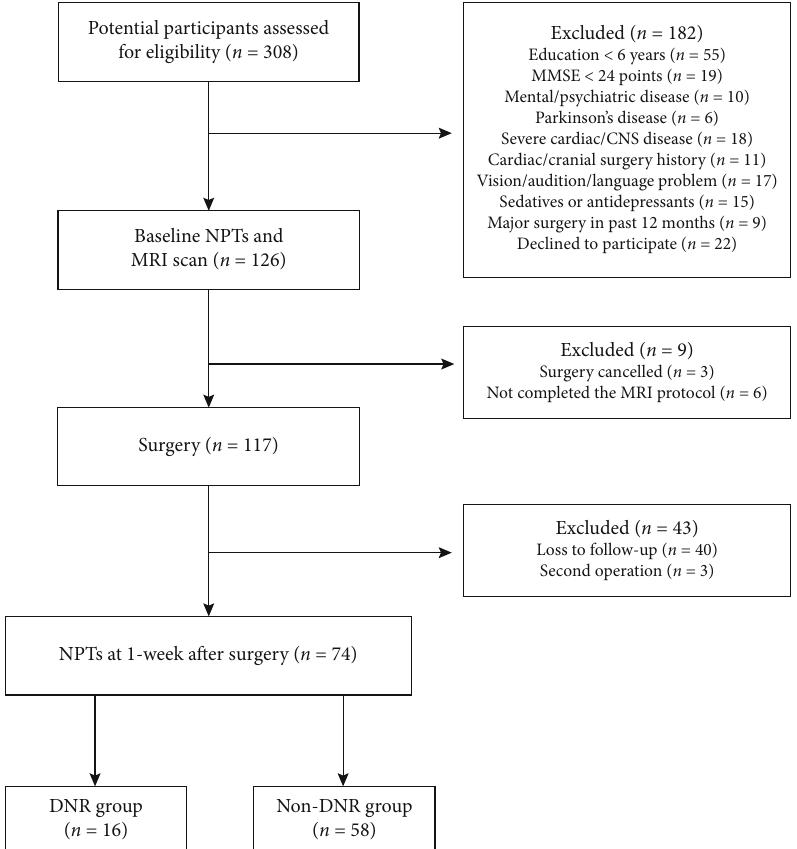
Figure 1: Strengthening the Reporting of Observational Studies in Epidemiology (STROBE) diagram. CNS: central nervous system; DNR: delayed neurocognitive recovery; MMSE: Mini-Mental State Examination; MRI: magnetic resonance imaging; NPTs: neuropsychological